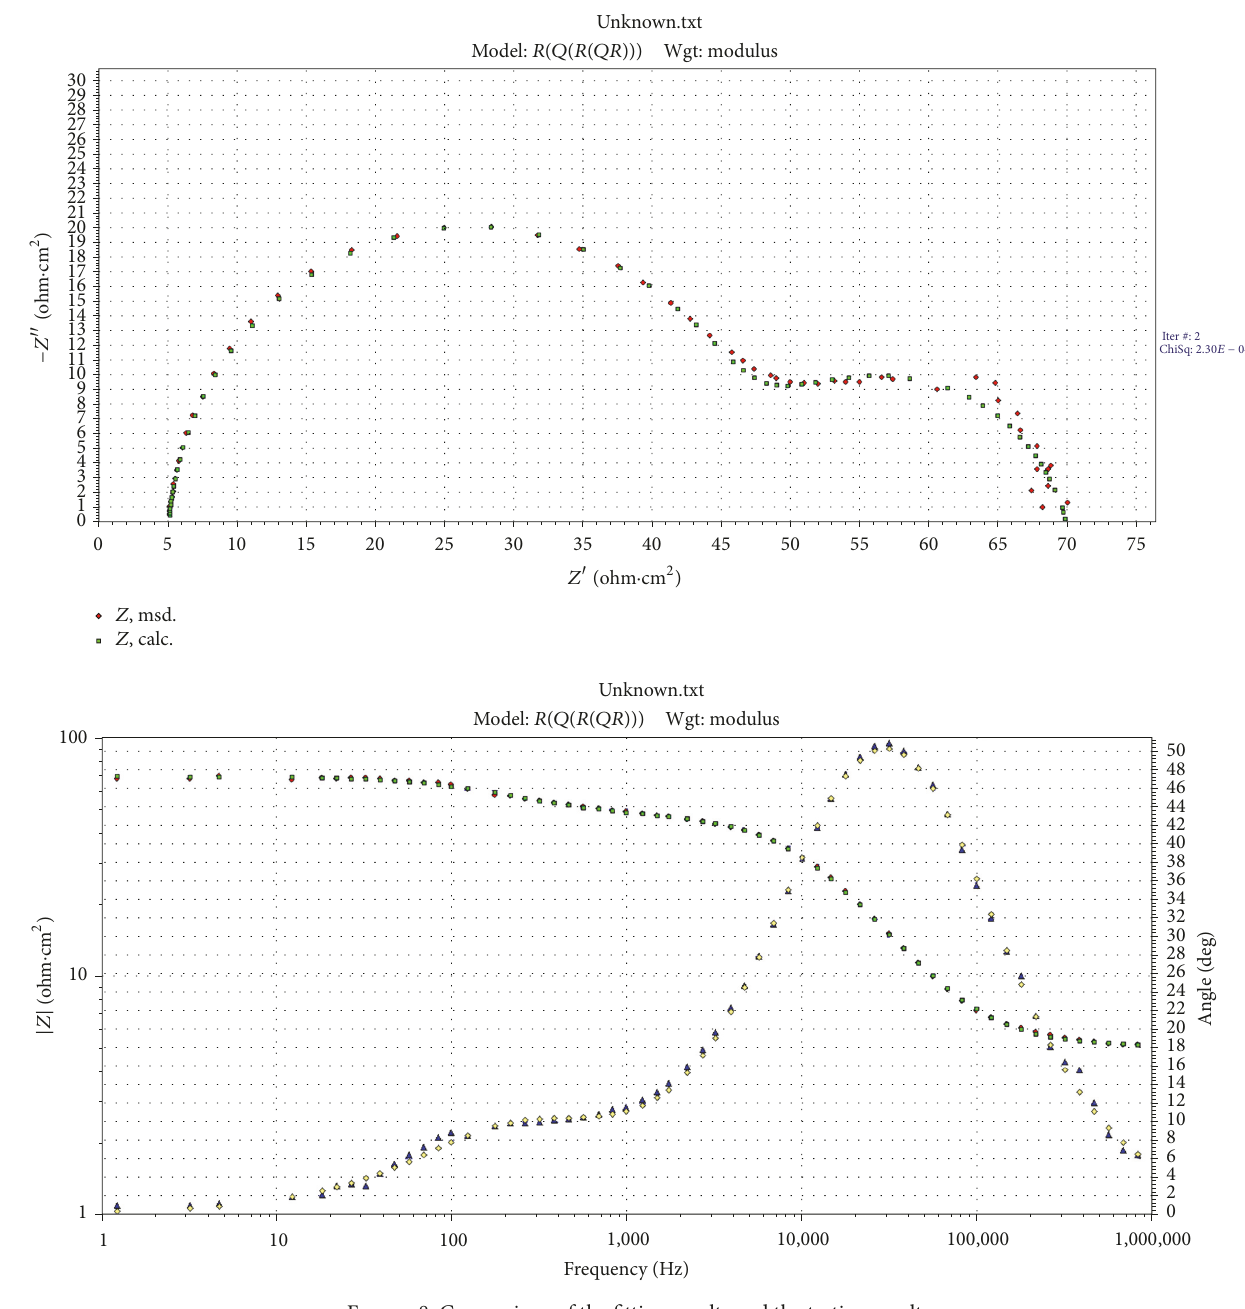
Figure 8: Comparison of the fitting results and the testing